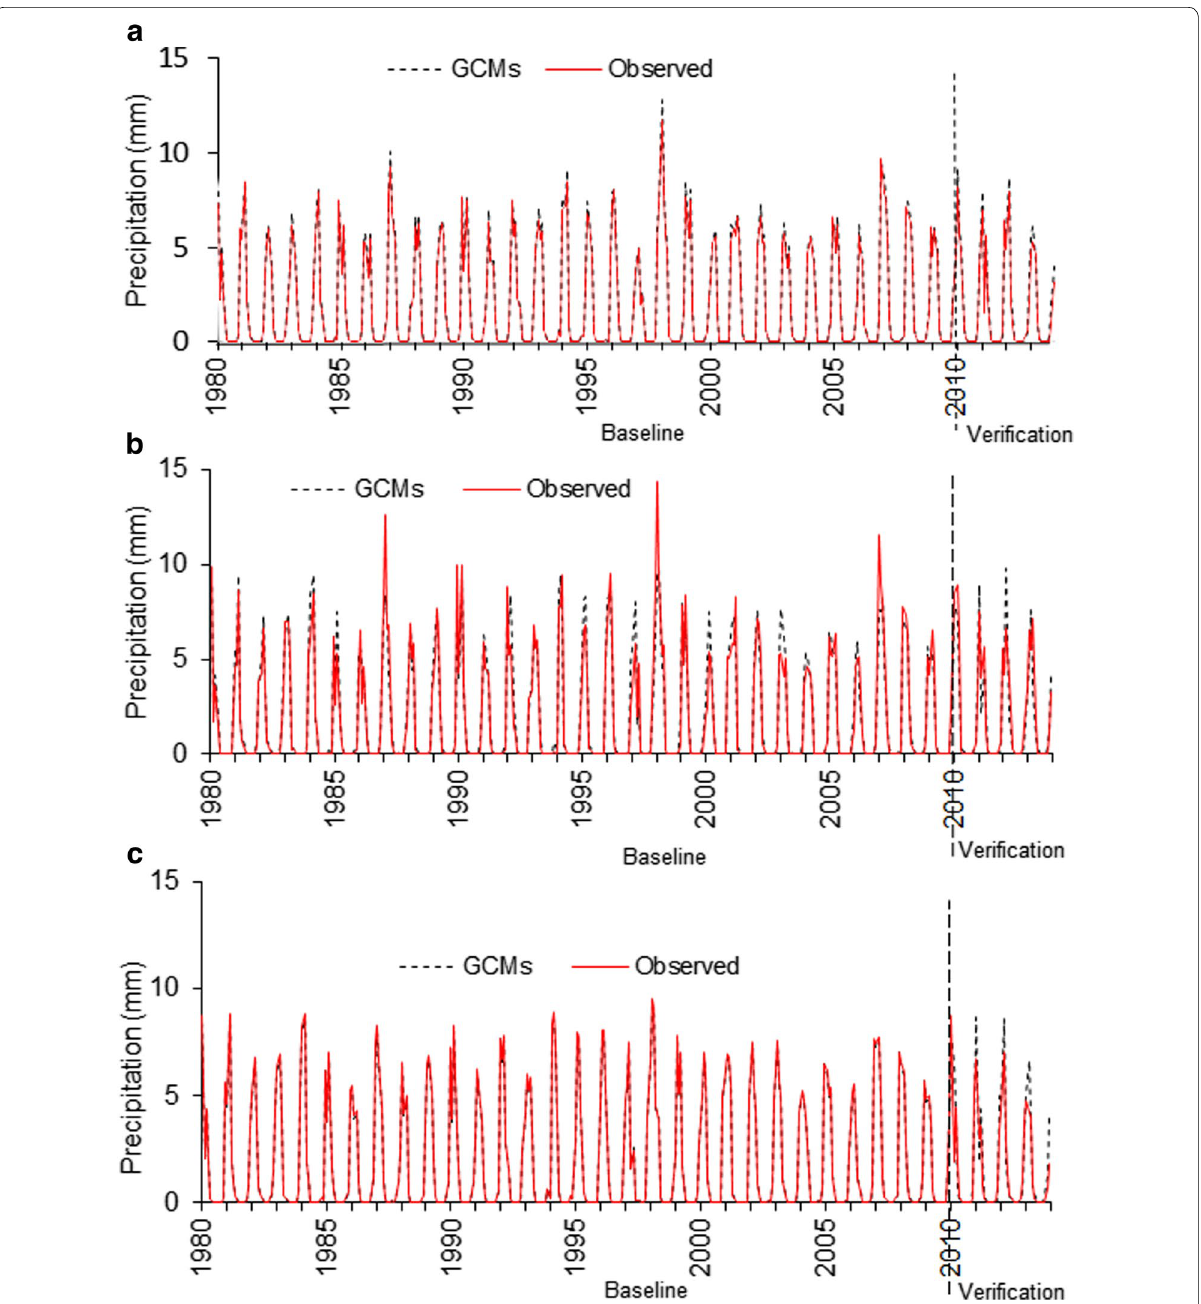
Fig. 12 Observed and GCMs-derived mean monthly precipitation for the three weather stations ( a Kihanga, b Ikweha and c Kinyanambo) during baseline and verification